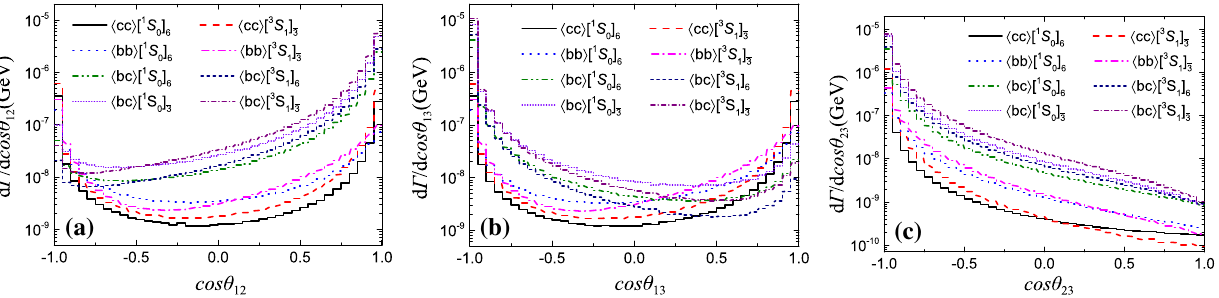
, (cid:4) bc (cid:5)[ 3 S 1 ] ¯ , (cid:4) bc (cid:5)[ 1 S 0 ] ¯ , (cid:4) bb (cid:5)[ 1 S 0 ] 6 and (cid:4) bb (cid:5)[ 3 S 1 ] ¯ 3 3 / 6 3 / 6